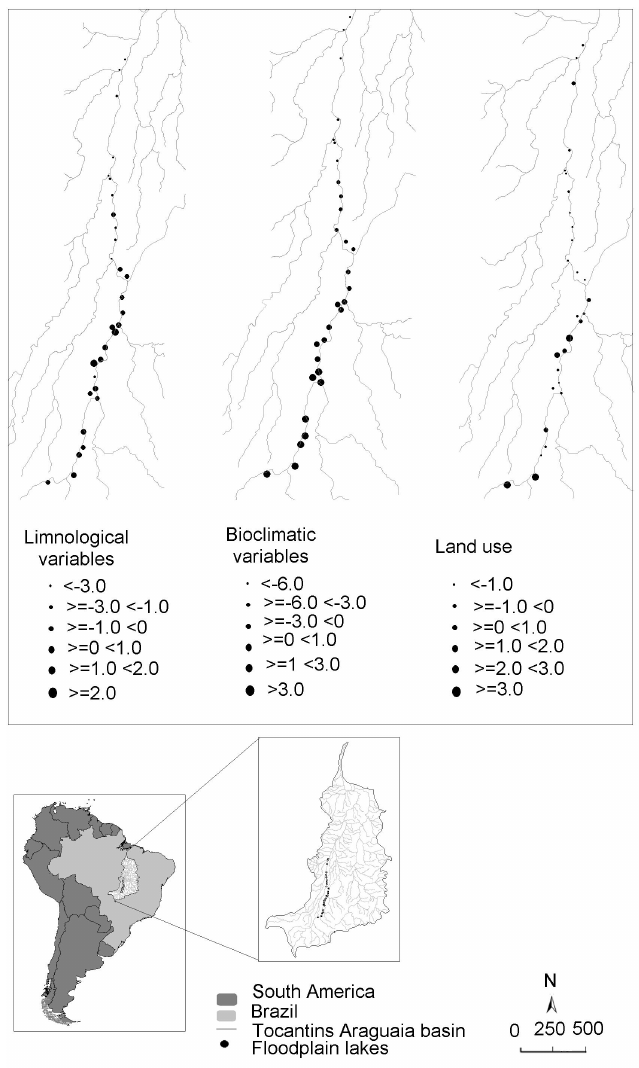
Figure 3. Spatial variation of limnological, climate and land use variables along the Araguaia River. These maps were constructed using the first principal component of principal component analysis.